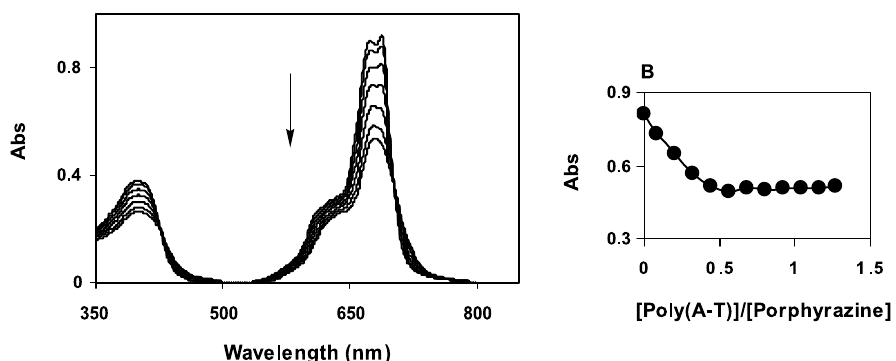
Fig. 2. (A): Absorption spectra of Zn (tmtppa) (14 . 5 (cid:1) M) in the presence of poly (A-T): 0, 0.16, 0.32, 0.48, 0.63, 0.78, 0.94, 1 . 09 (cid:1) M. The arrow indicates the absorbance changes with increasing [poly (A-T)]. (B) The variation of absorbance at the Q-band (688 nm) versus mole ratio of poly (A-T) to Zn (tmtppa).